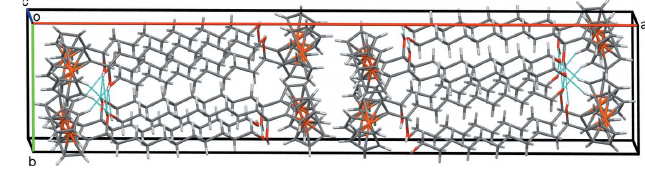
Figure 5 Overall packing of 1 viewed along the c -axis direction.